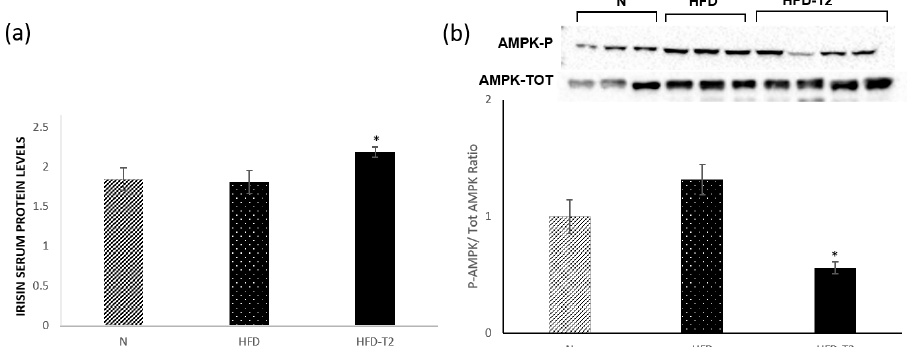
Figure 9. Effects of T 2 administration on Irisin and P-AMPK in sWAT. ( a ) Irisin serum levels detected by a competitive Enzyme Linked-Immunosorbent Assay (ELISA) and ( b ) immunoblot and densitometry showing relative expression of P-AMPK and total AMPK in sWAT lysates. Values are means ± SEM of five independent experiments. N = 5, * p < 0.05 vs. N and